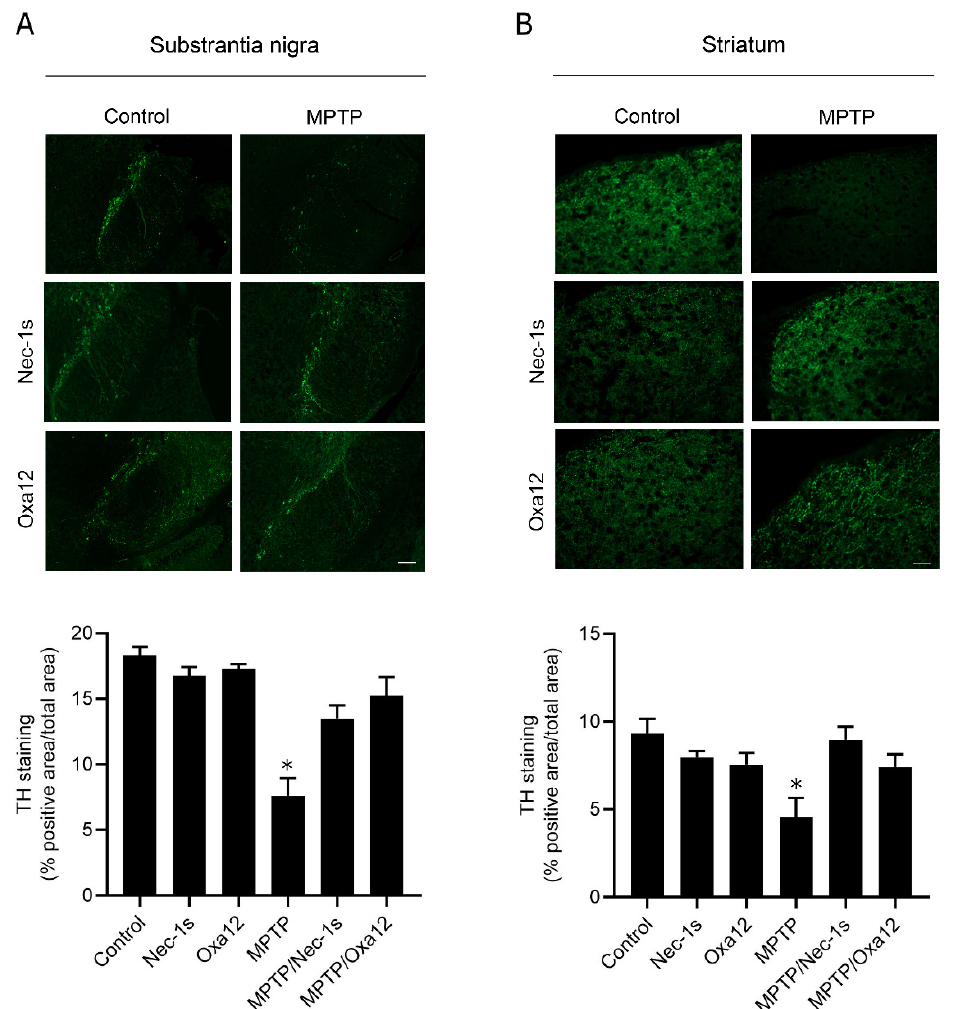
Figure 3. Oxa12 protects from MPTP-driven dopaminergic neuronal loss. Representative images of TH-positive immunostaining from control- and MPTP-injected mice treated with vehicle, Nec-1s or Oxa12 in the SN ( A ) and the striatum ( B ), and respective quantification. Scale bar, 100 µm. * p < 0.05 vs. control mice.